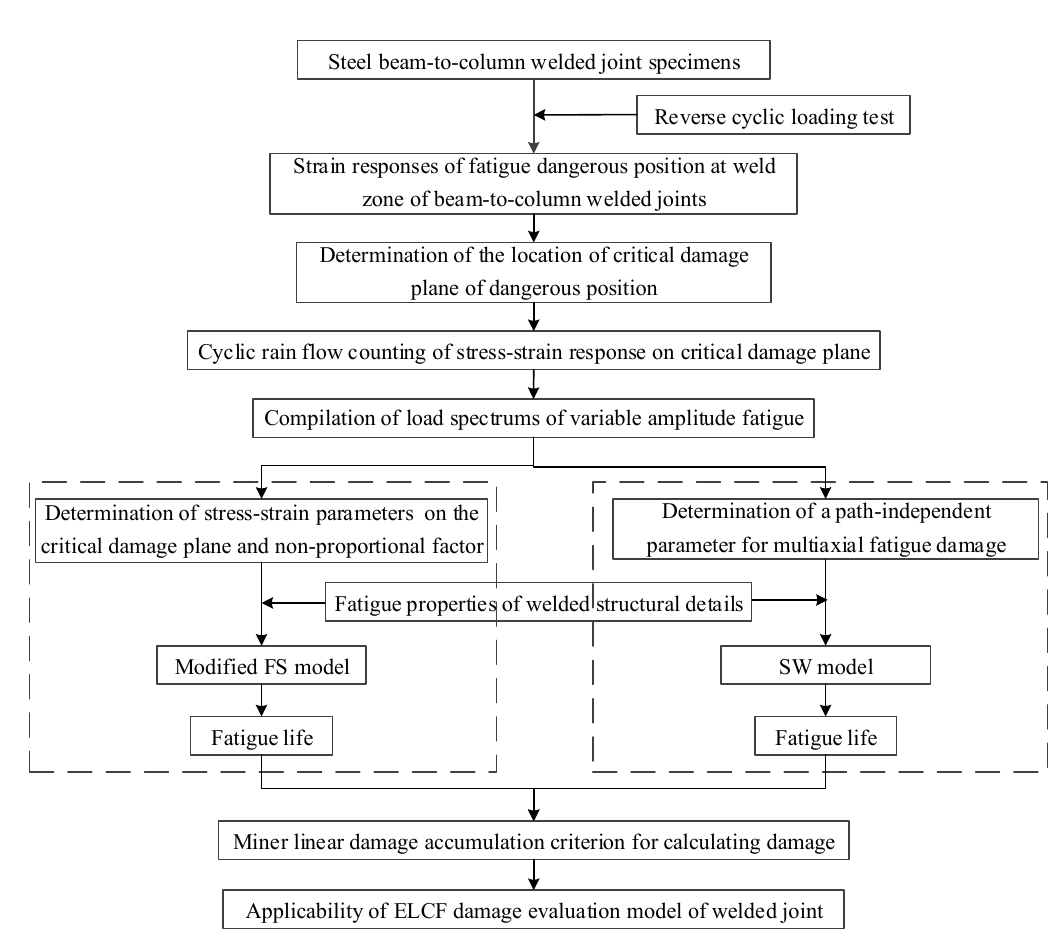
Figure 9. Extremely-low-cycle fatigue ( ELCF) damage analysis steps.